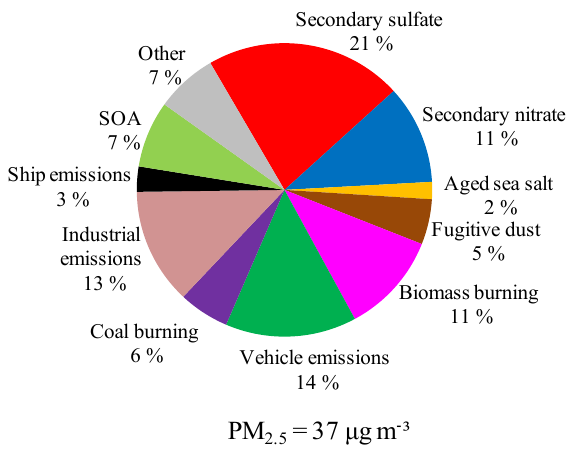
Figure 5. The 4-month average contributions of PM 2 . 5 sources in the